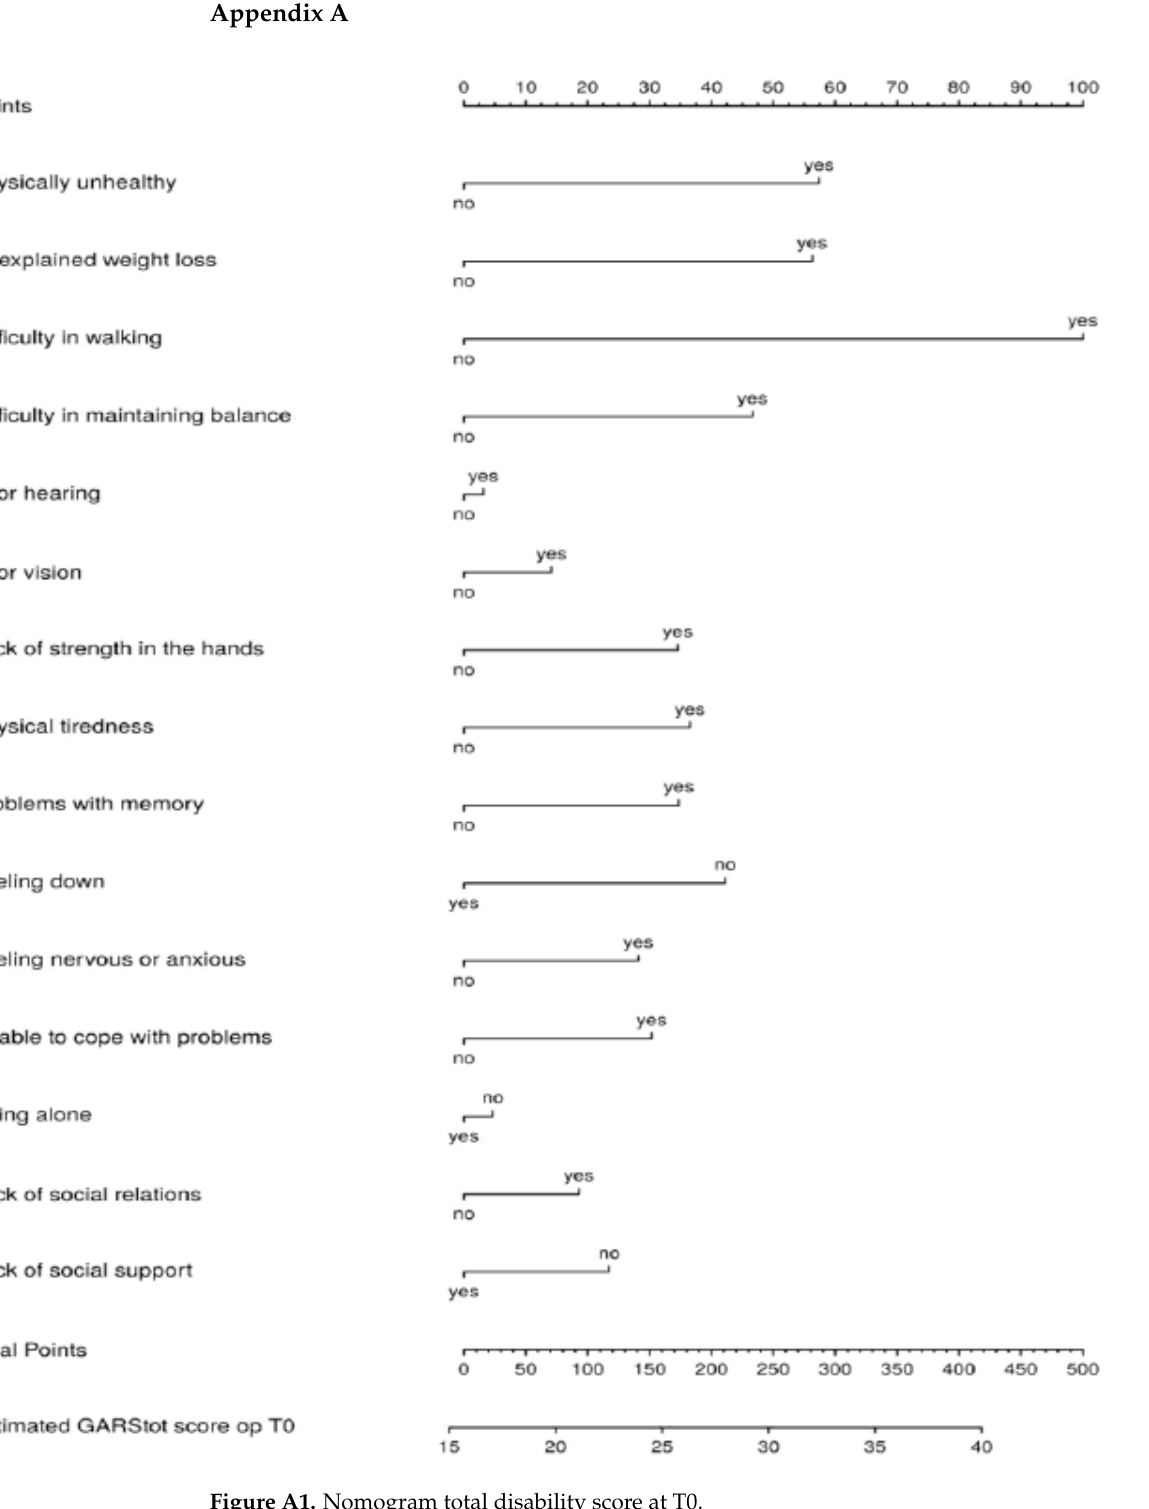
Figure A1. Nomogram total disability score at Figure 1. Nomogram total disability score at T0.